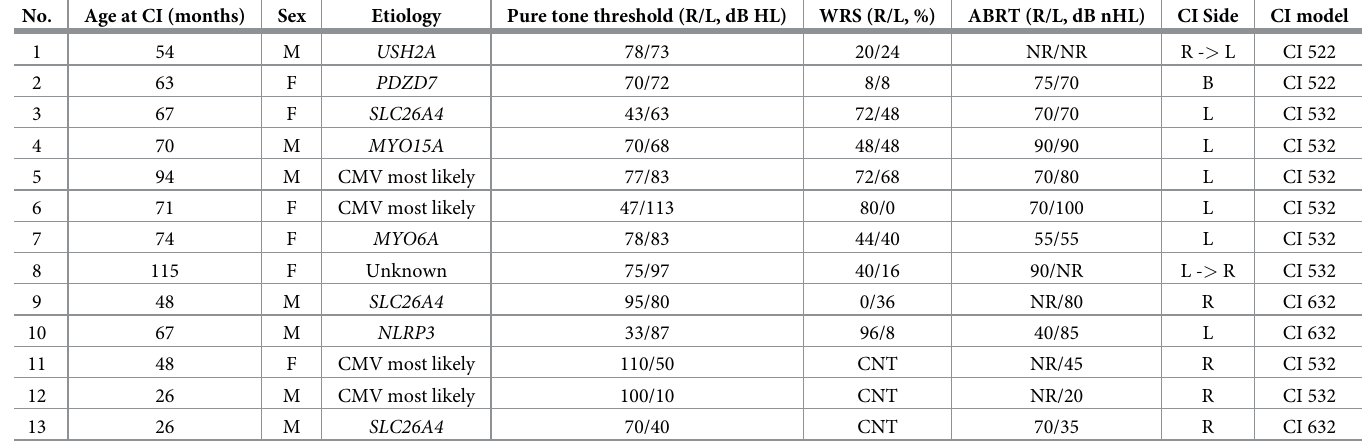
Table 1. Characteristics of subjects